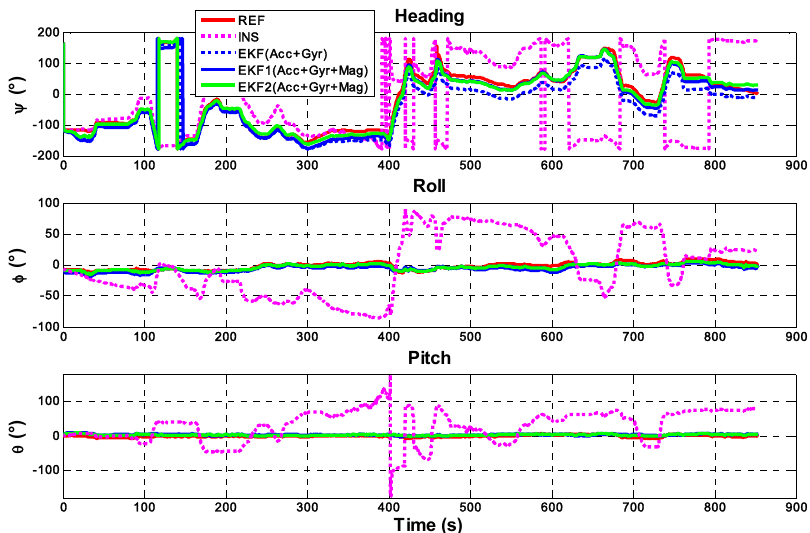
Figure 5. The attitude angles derived from different attitude estimation solutions.